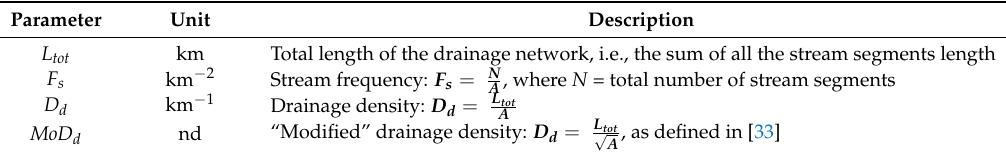
Table A3. Parameters describing the network texture.